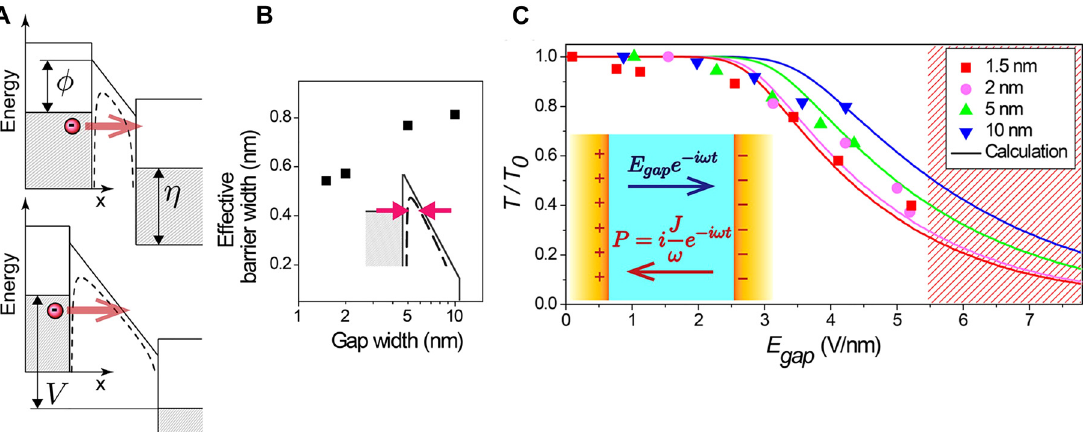
Figure 7: Nonlocal effects in few-nanometer-wide gaps. (A)Tunnelingofanelectronthroughabarrierofheight ϕ ,wheredashedlinesdepicttheeffectivebarriertakingtheimageforceintoaccount.Witha strong electric fi eld inside the gap E gap , Fermi level η of the two metals separate by V = eE gap w which narrows the effective barrier width. (B) Calculatedeffectivebarrierwidthsfordifferentgapwidths.(C)Nonlinearterahertztransmittanceasafunctionof E gap ingapswithdifferentgapsizes due to transient tunneling current J e − i ω t inducing an additional negative polarization P within the gap. Reproduced with permission from